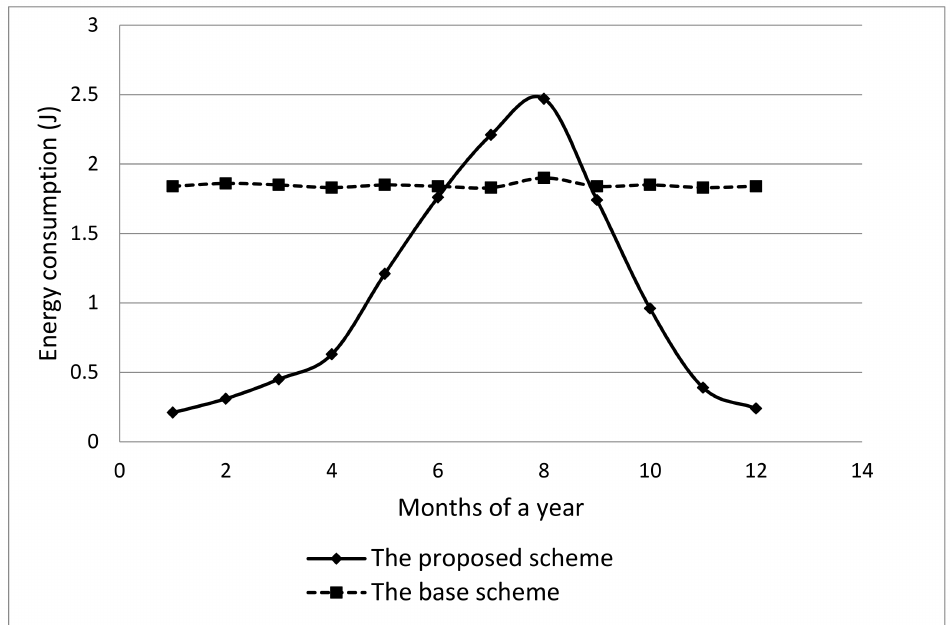
Figure 8. Energy Consumption of the proposed and base schemes.